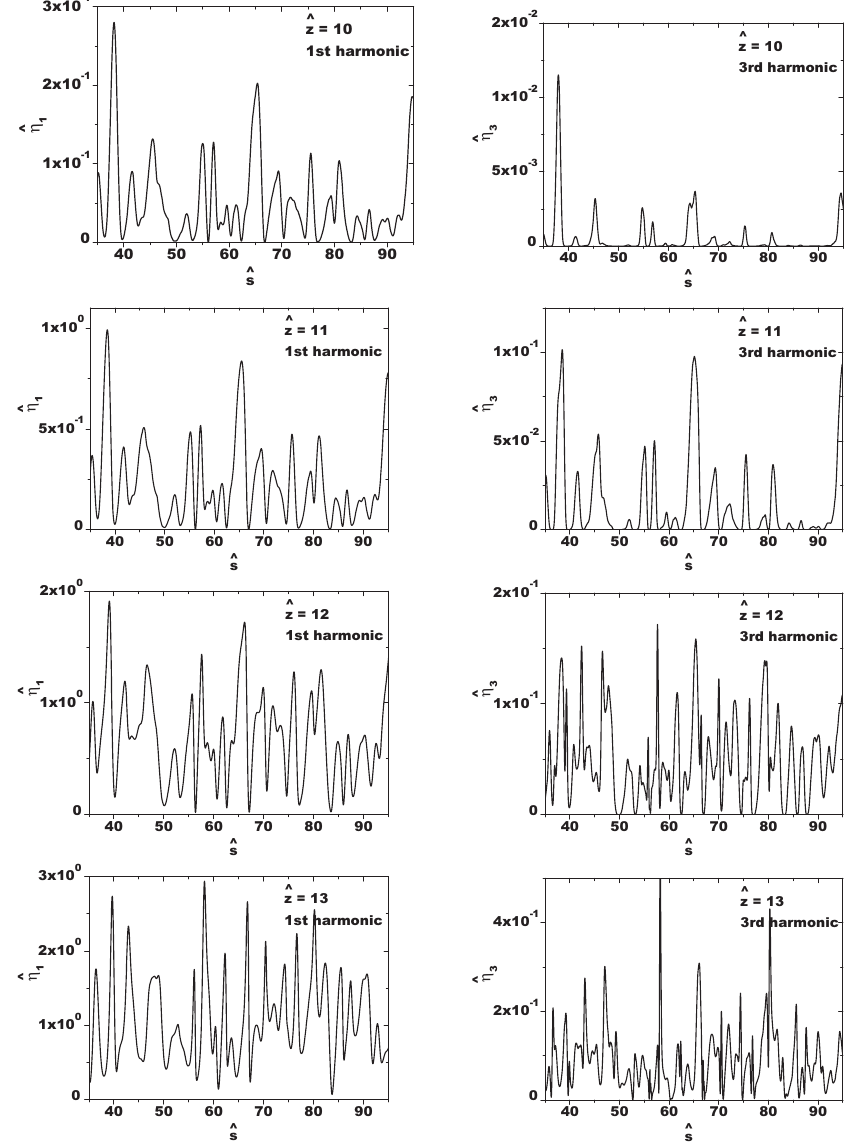
(cid:1) z= (cid:3) v (cid:5) t (cid:2) at different lengths of the FEL amplifier ^ z (cid:3) 10 – 13 . Left z 0